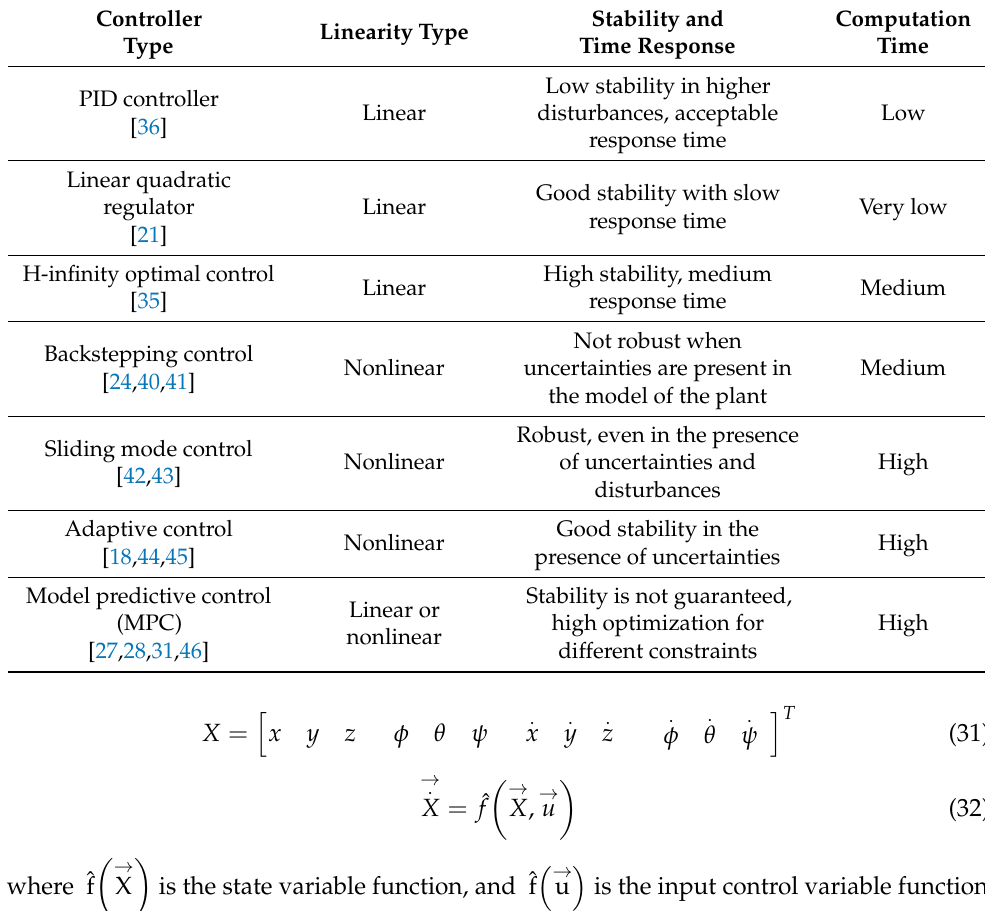
Table 2. Parameters of the Tello